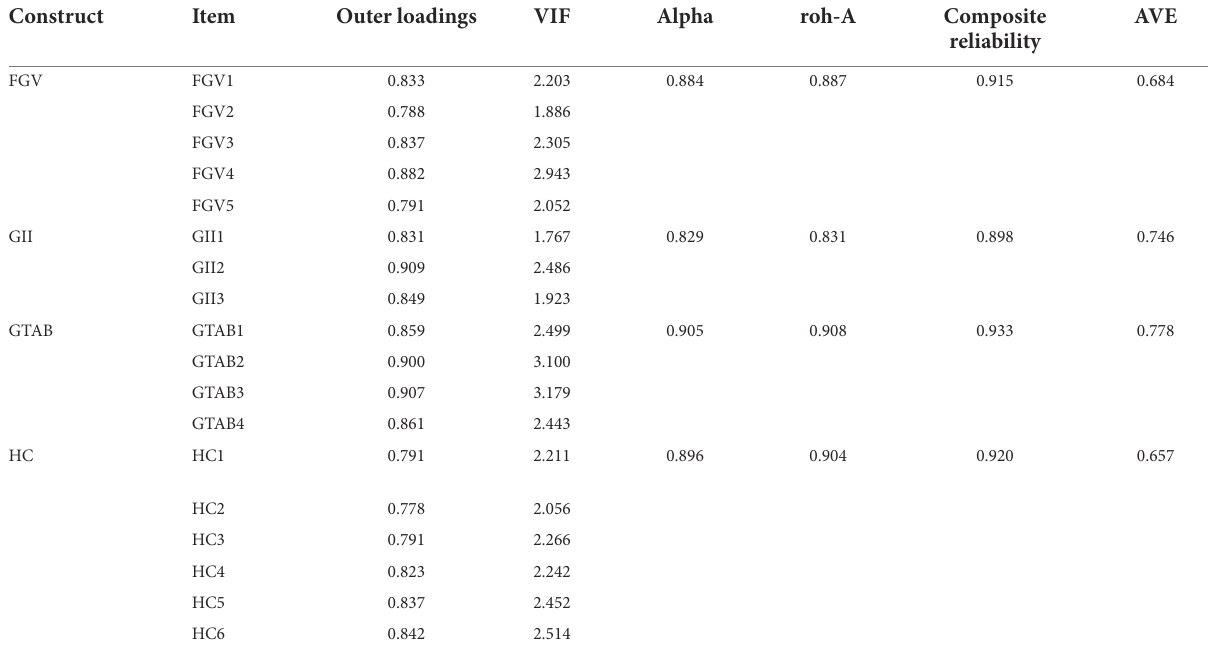
TABLE 1 Reliability and convergent validity of the study constructs.